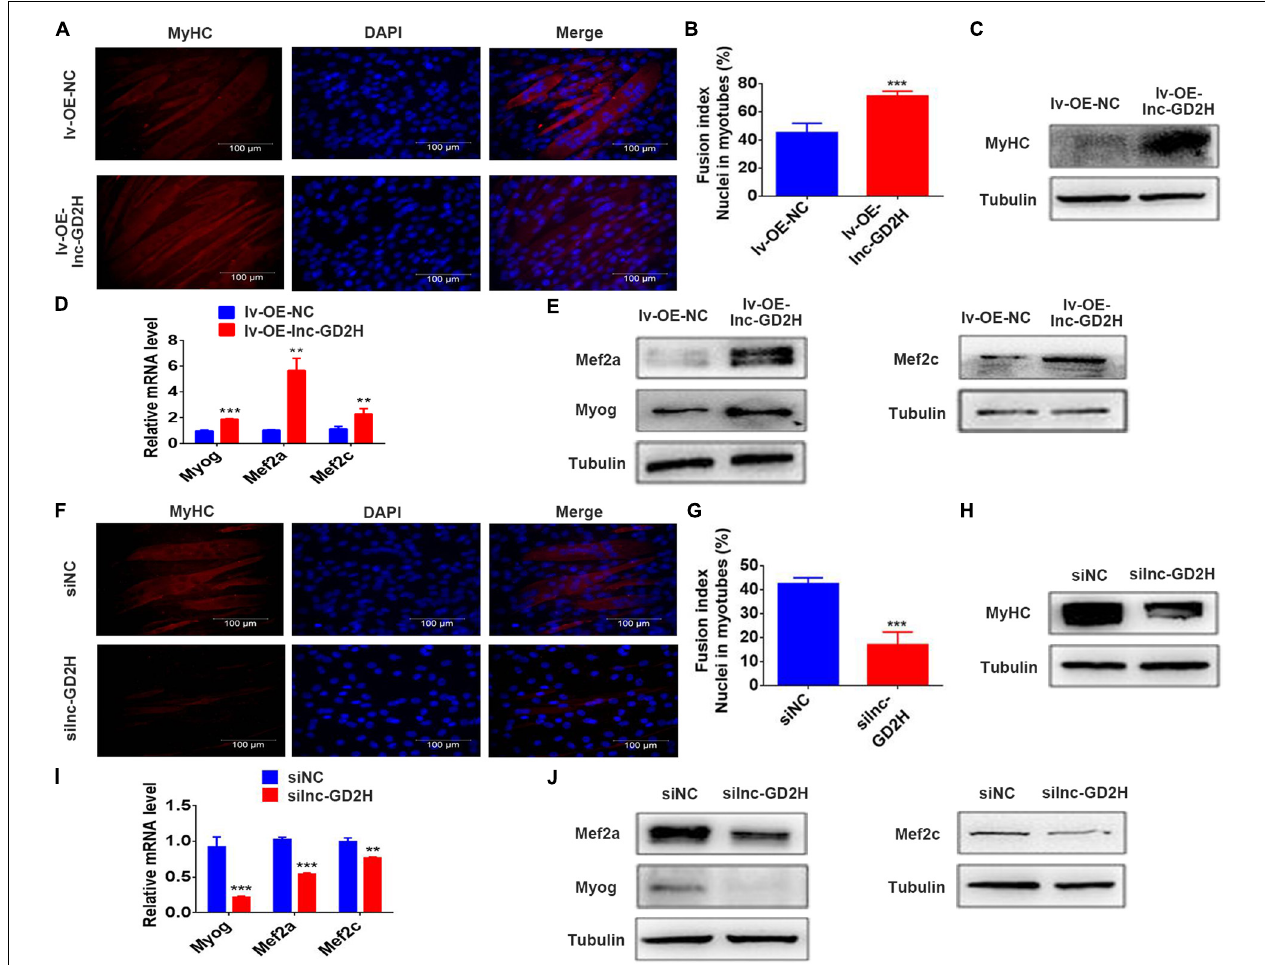
FIGURE 5 | Lnc-GD2H promoted cell differentiation during myoblast differentiation. The differentiation of lnc-GD2H-overexpressing C2C12 cells in differentiation medium was detected by staining for MyHC (A,B) the fusion index was calculated. (C) MyHC protein levels were detected using western blotting. The mRNA levels (D) and protein levels (E) of Myog, Mef2a, and Mef2c were detected using qPCR and western blotting in lnc-GD2H-overexpressing C2C12 cells. Knockdown of lnc-GD2H decreased myogenic differentiation as evidenced by less MyHC staining (F) , a reduced fusion index (G) , lower MyHC protein levels (H) , and decreased mRNA (I) and protein levels (J) of Myog, Mef2a, and Mef2c. n = 3, ** P < 0.01, and *** P <